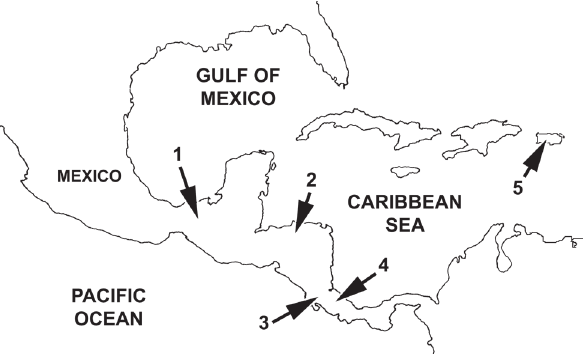
Figure 18. Distribution of the exotic cyclopoid copepod Mesocyclops thermocyclopoides in the Neotropical region: 1) Tabasco, Mexico (G UTIÉRREZ -A GUIRRE et al. 2003); 2) El Progreso, Honduras (M ARTEN et al. 1994; G UTIÉRREZ -A GUIRRE et al. 2003); 3) different areas of Costa Rica (C OLLADO et al. 1986); 4) El Arenal, Costa Rica (this work); 5) Puerto Rico (M ARTEN